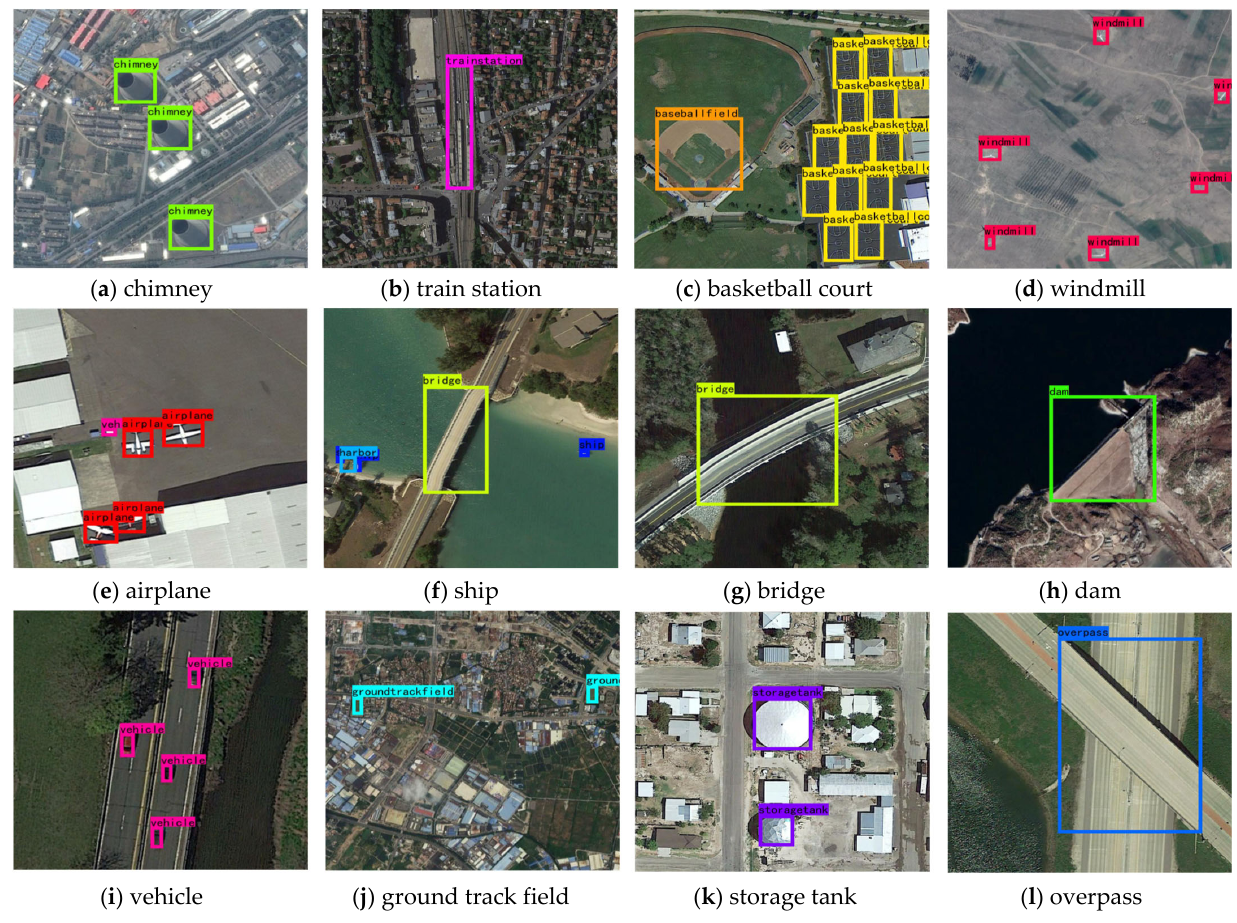
Figure 11. The detection results of our method on the DIOR dataset. Table 5. Ablation experimental results on the RSOD dataset.